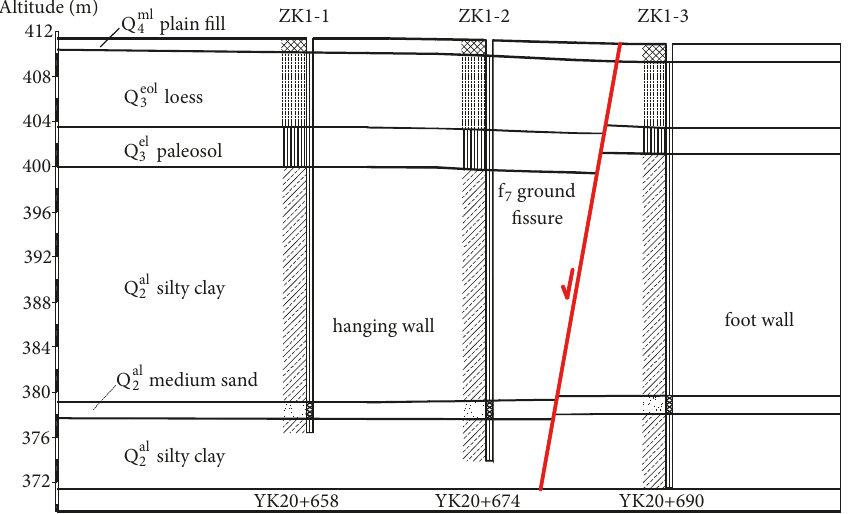
Figure 2: Typical strata of ground fissure f 7 .